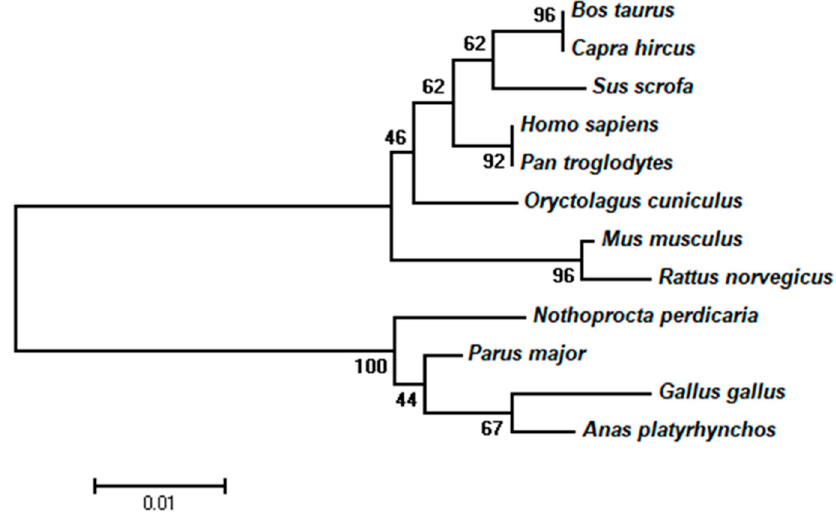
Figure 1. Phylogenetic tree constructed based on the PITX2 amino acid sequence of 12 species. Branches were labeled with species’ Latin names. The number above each branch represented bootstrap values.